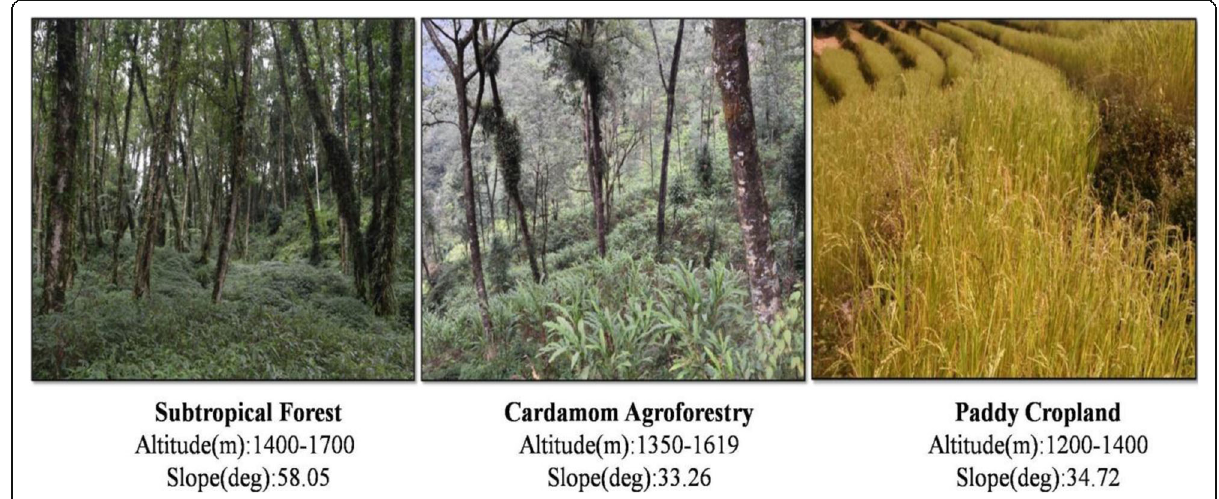
Fig. 1 Picture of the three different study sites along with altitude and